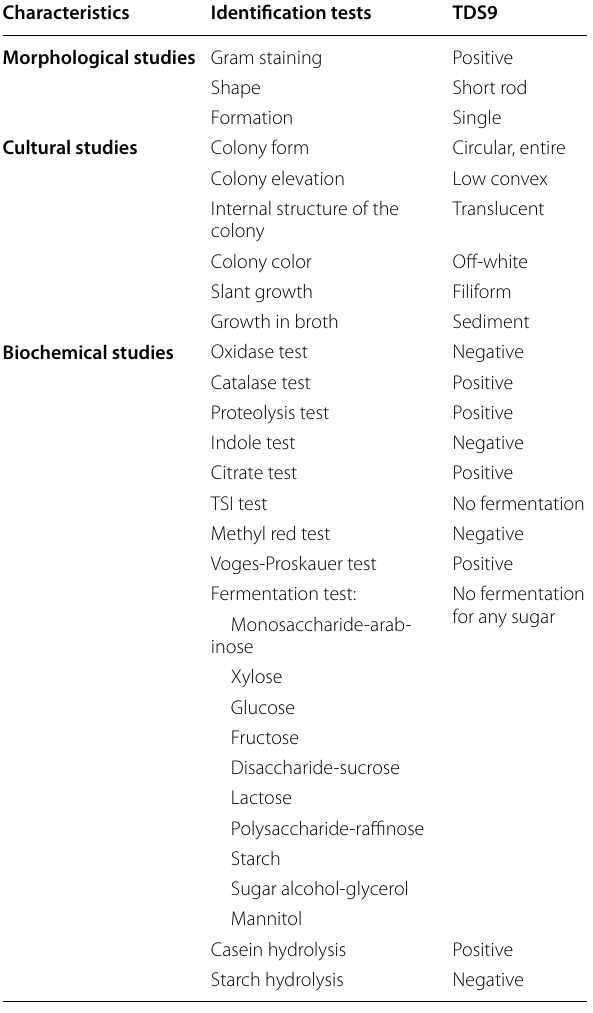
Table 2 Morphological, cultural, and biochemical characteristics of the bacterial strain TDS9 Characteristics